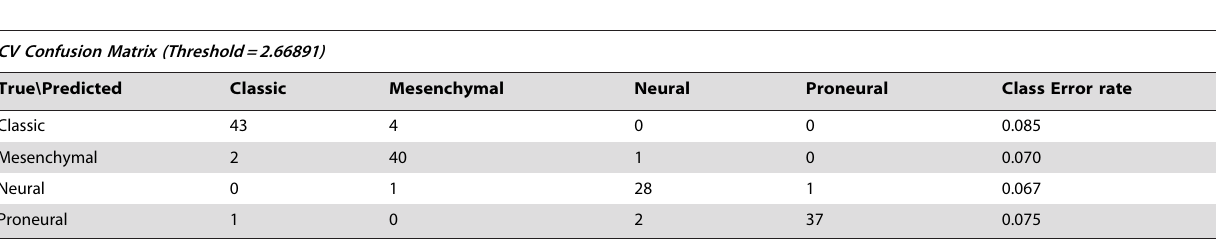
Table 1. Classification accuracy of subtype predictor on the training set of TCGA samples generated using Prediction Analysis of Microarrays (PAM) software.